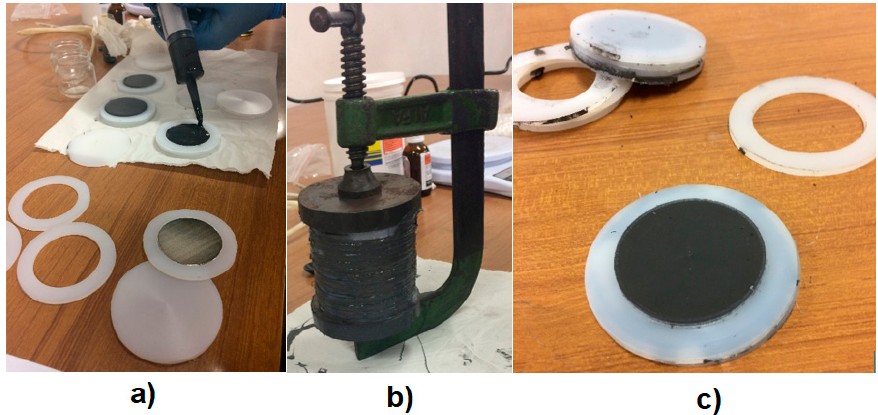
Figure 5. ( a ) Mold elements; ( b ) pouring phase; ( c ) MRE sample. Table 1. MRE sample characteristics.